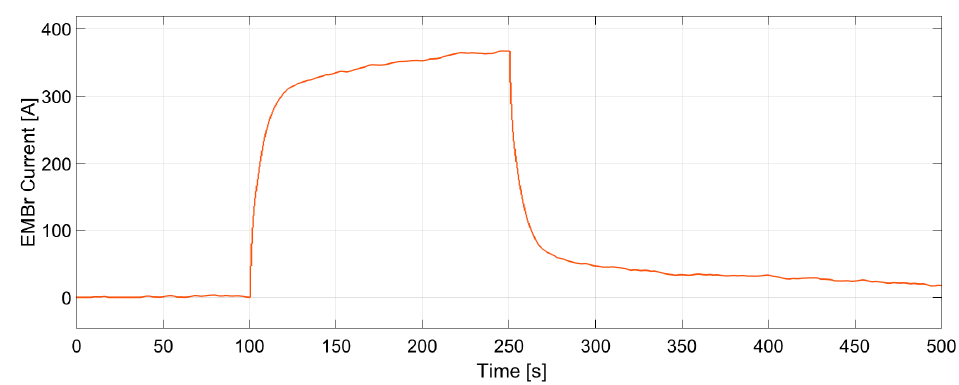
Figure 15. Closed loop response of jet velocity for set-point tracking.